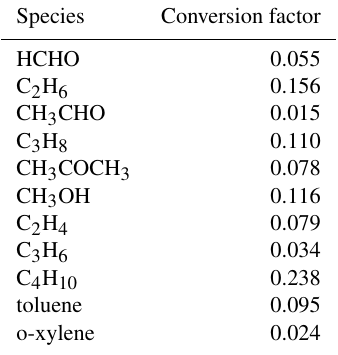
into account observations described by Brookes et al.